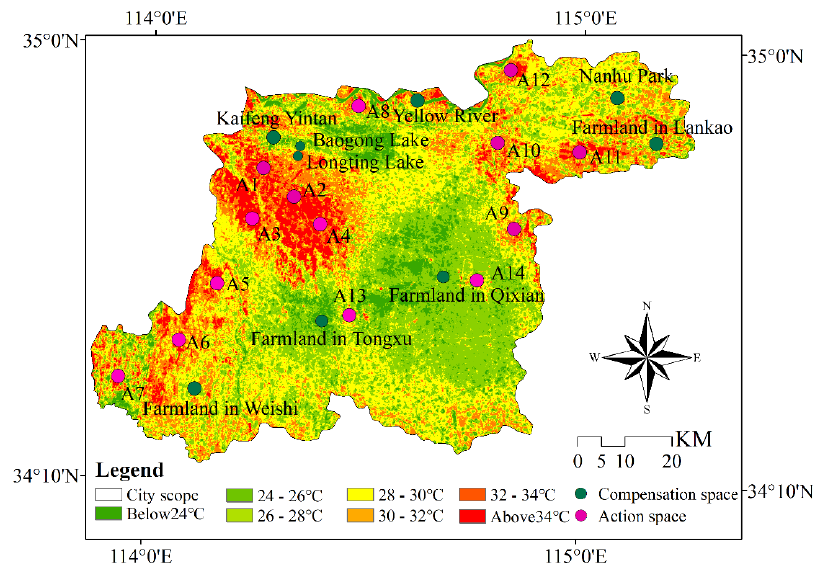
Figure 5. Action space and compensation space of the ventilation system in Kaifeng.